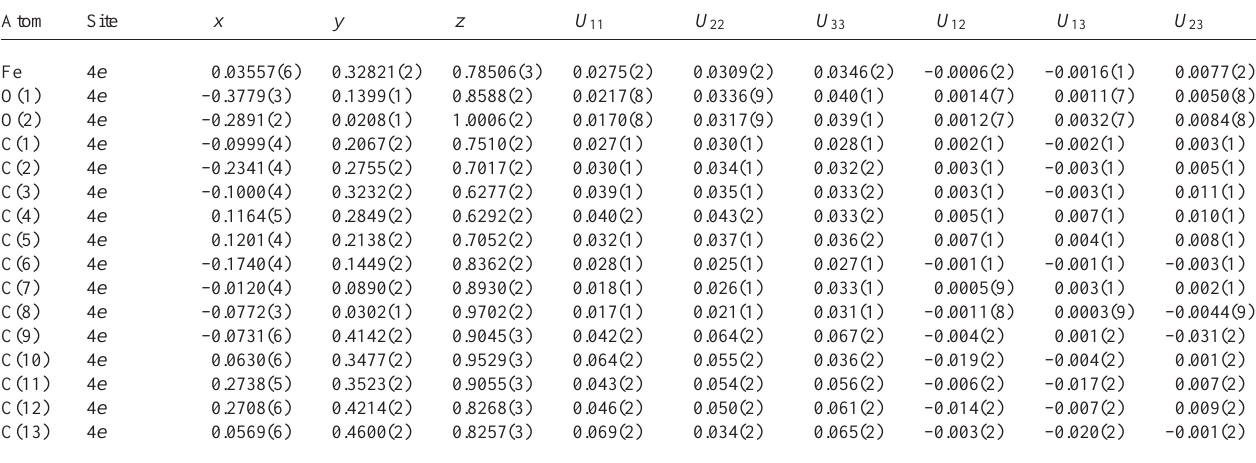
Table 3. Atomic coordinates and displacement parameters (in Å 2 )